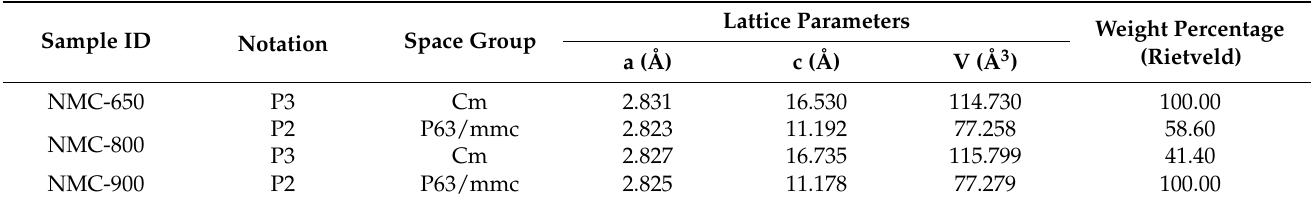
Table 1. Crystallographic parameters of Na x Mn 0.5 Co 0.5 O 2 materials prepared at di ff erent calcination temperatures of 650, 800 and 900 °C. Sample ID